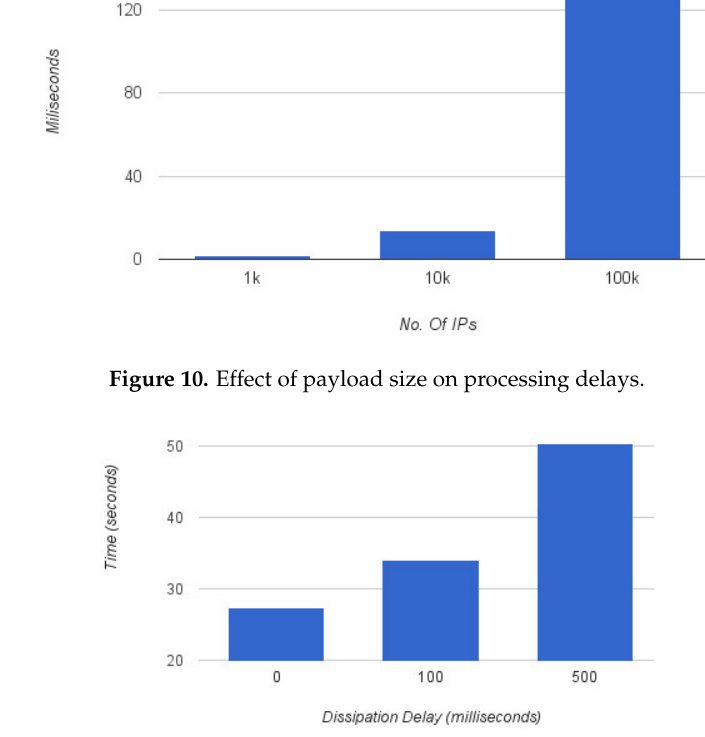
Figure 11. Central Platform: Load testing at varying